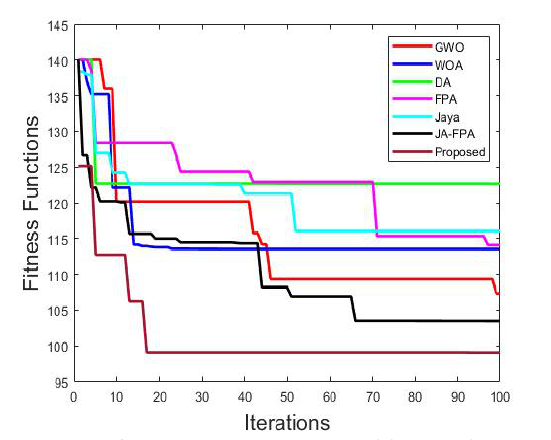
Figure 7. Analysis of Power-loss